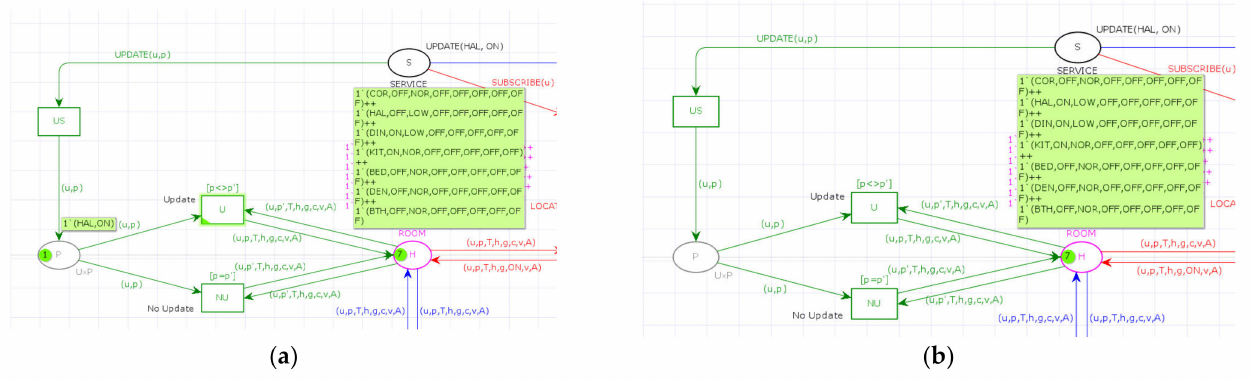
Figure 2. Update service behavior. In ( a ), transition U is enabled by request on place P . In ( b ), the effect of changing the notebook contents of place H is